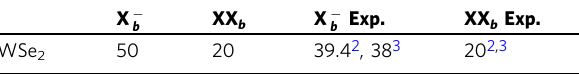
Fig. 1 Exciton, trion, and biexciton optical spectra and eigenstates. a Biexciton spectrum (biexciton to exciton recombination) in blue together with trion and exciton spectra in red and black, respectively. b Exciton, trion, and biexciton eigenvalue manifolds. The dark – dark (DD) manifold indicates a series of dark biexciton states. The DB 1 and the BB 1 states are the fi rst dark – bright (DB) and bright – bright (BB) states in the spectrum, respectively. For exciton, D and B are the dark and bright states, whereas for trion, S and T are the singlet and triplet states, respectively. The biexciton peaks XX 1,2 originate from the DB 1 → D transition with a fi ne structure determined mainly by the lifted double degeneracy in the D state under the electron – hole exchange interaction. On the other hand, for trions, the fi ne structure results from the splitting of the fi rst bright trion state into S and T states, which recombine to the conduction band minimum (CBM). c Schematics of the main con fi gurations entering the formation of the many-body states introduced in b . Dark circles indicate a dark exciton state, whereas gray circles indicate a bright one. Table 1 Binding energy of trions and biexcitons in WSe 2 . Table 2 Fine structure of trions and biexcitons in WSe 2 monolayer